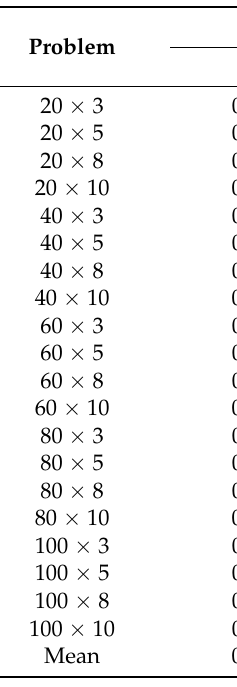
Table 12. IGD -metric for SDABC and